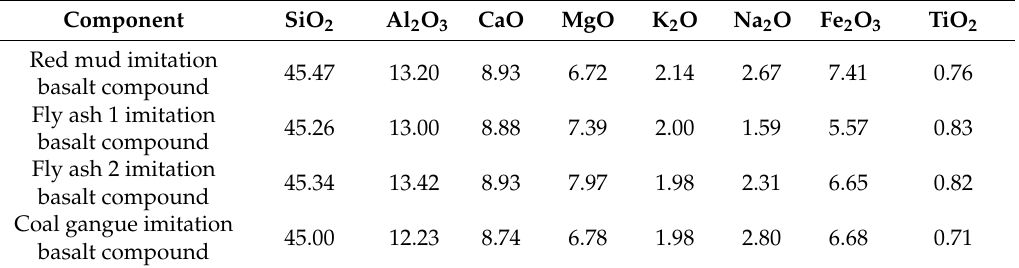
Table 4. The chemical compositions of imitation basalt compounds (wt.%).